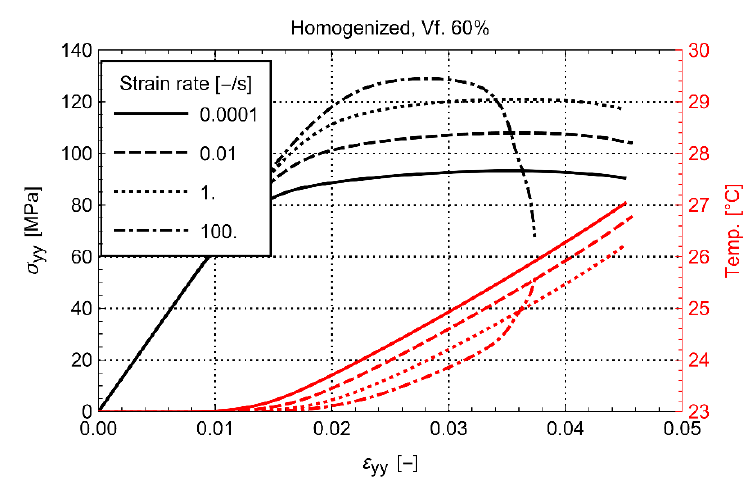
Figure 8. Effect of strain rate on homogenized stress-temperature-strain for Vf. 60%.